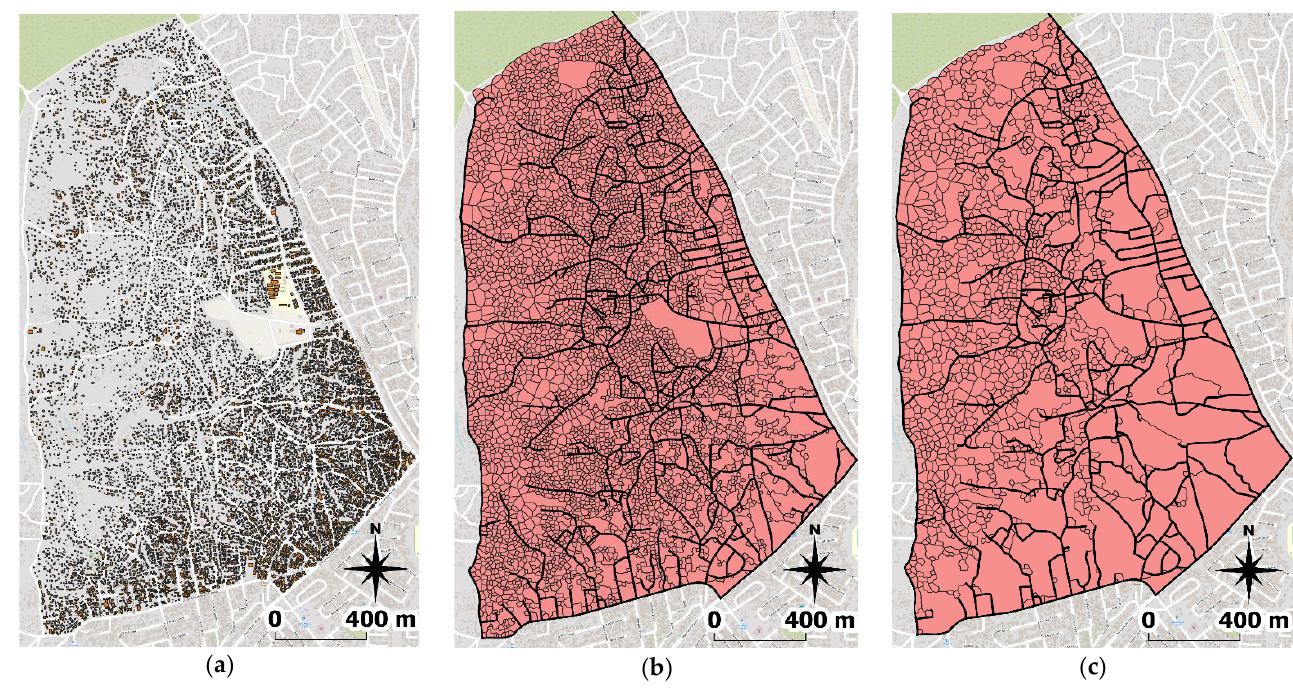
Figure 4. Area of interest ( a ); basic area creation at minimum distance >5 m ( b ); basic area creation at minimum distance >10 m ( c ) (basemap/buildings/polygons: [47]).